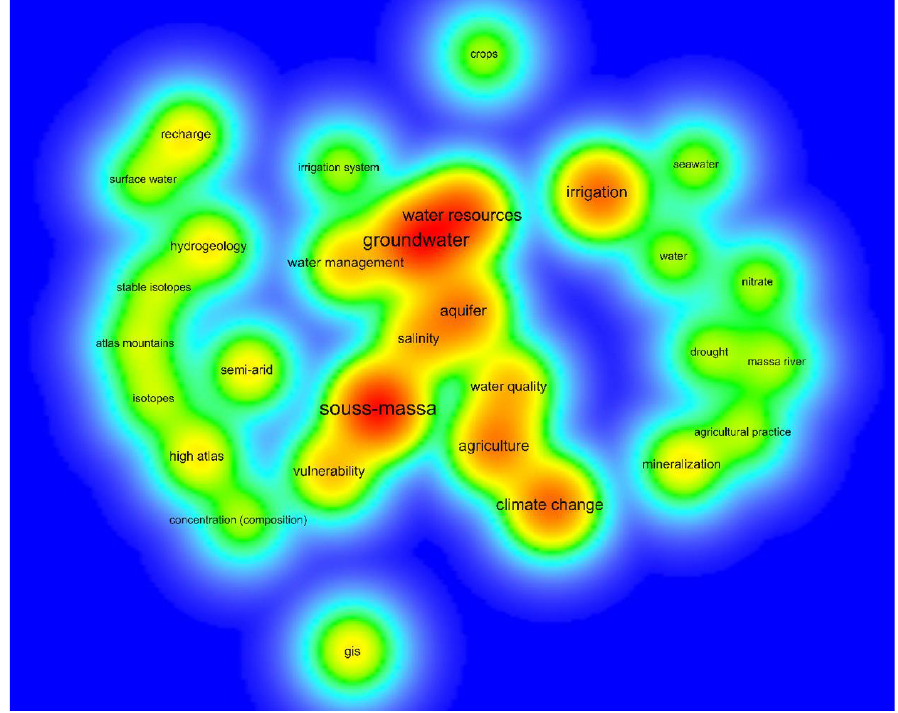
Figure 6. Map based on density visualization generated in VOSviewer from material from Scopus and WOS using co-occurrence of keywords.